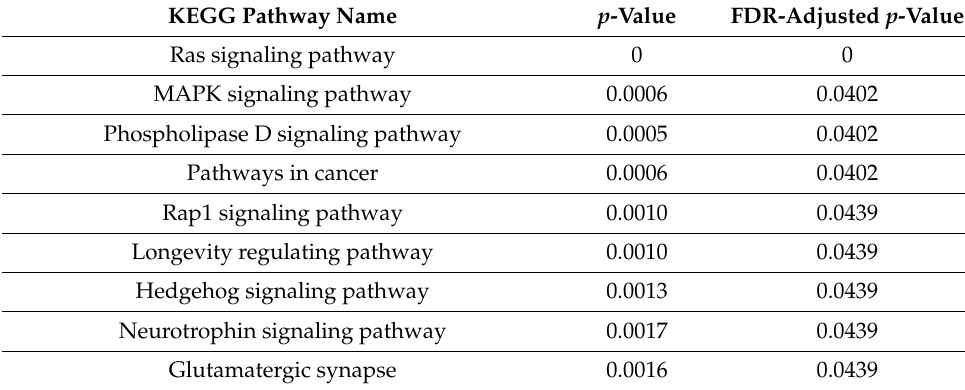
Table 3. KEGG pathways involving miR-136-5p, miR-376a-3p, and miR-150-5p targets found by miRWalk, filtered by FDR-adjusted p -value below